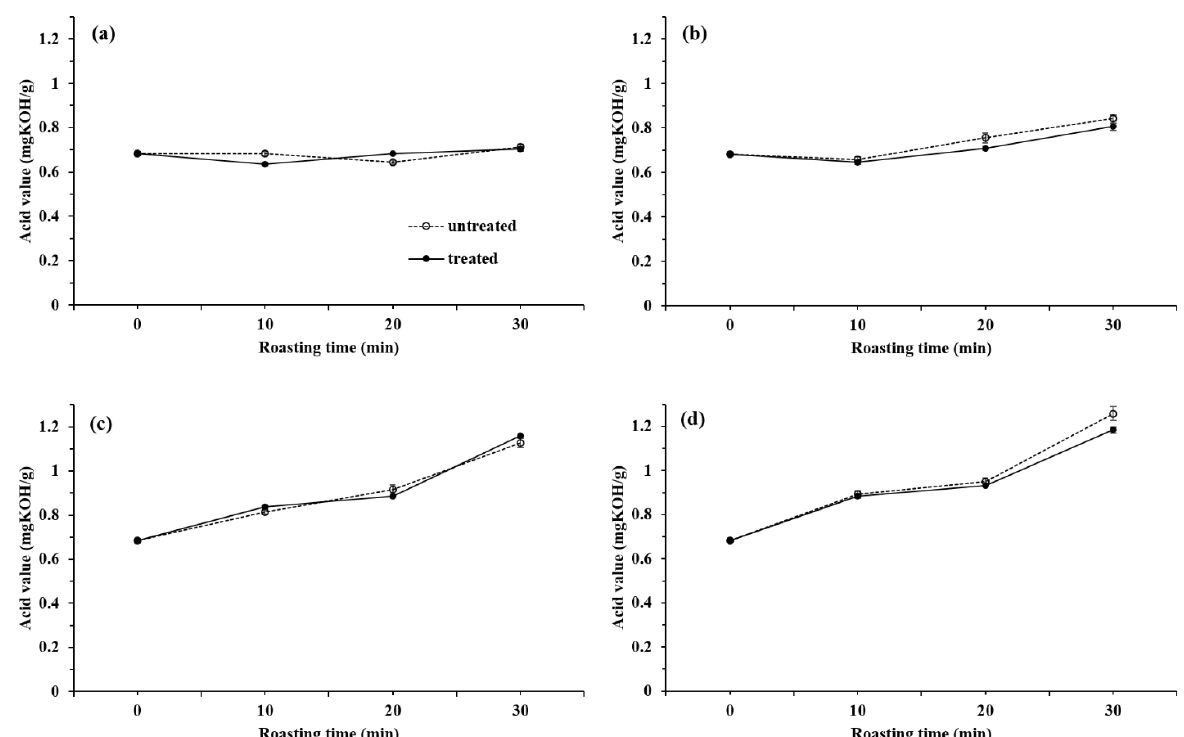
Figure 3. Acid value of sesame oil treated with and without 1% of the eulalia-based cellulosic aerogel under different roasting conditions; 150 °C ( a ), 180 °C ( b ), 210 °C ( c ), and 240 °C ( d ).The PV test was used as the index of the initiation step of oxidation.